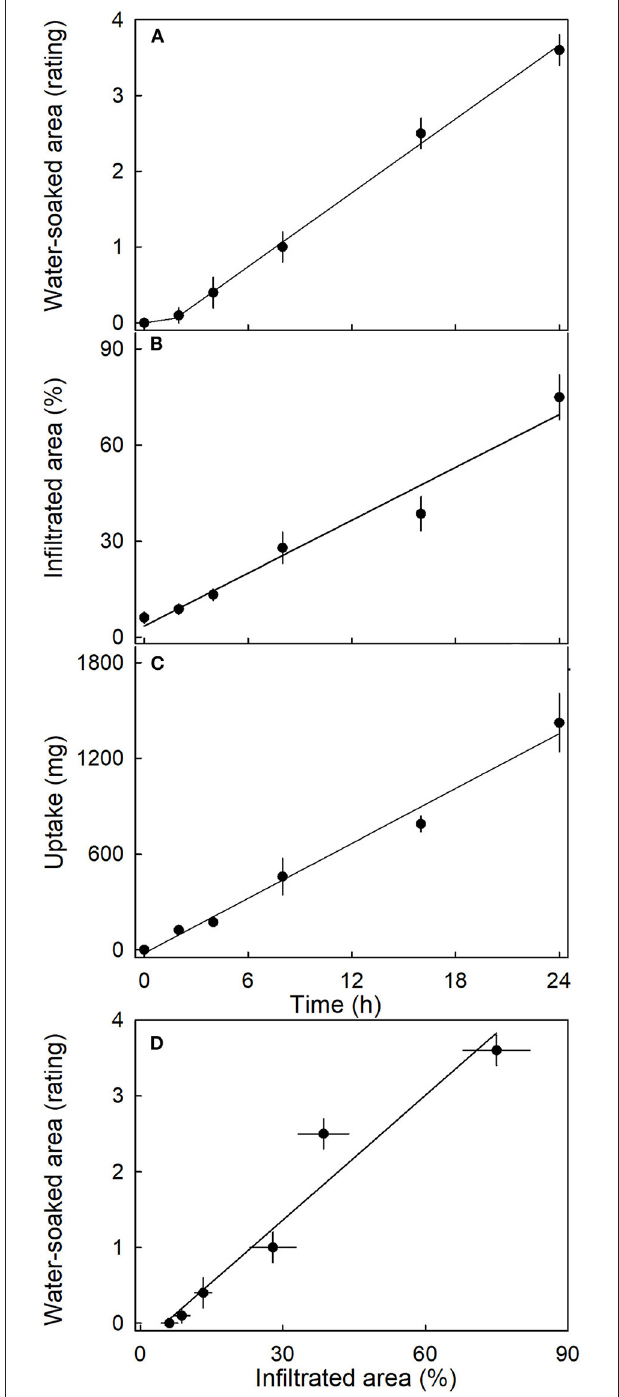
FIGURE 5 | Time course of (A) change in water-soaked area, (B) change in the area infiltrated by acridine orange, and (C) water uptake of strawberries incubated in deionized water. (D) Relationship between the water-soaked area and the area infiltrated by acridine orange. Acridine orange penetrates the strawberry fruit skin via microcracks in the cuticle. Water soaking was indexed using a 5-point rating scale: score 0, no water soaking; score 1, < 10% of the surface area water-soaked; score 2, 10–35%; score 3, 35–60%; score 4 > 60%.